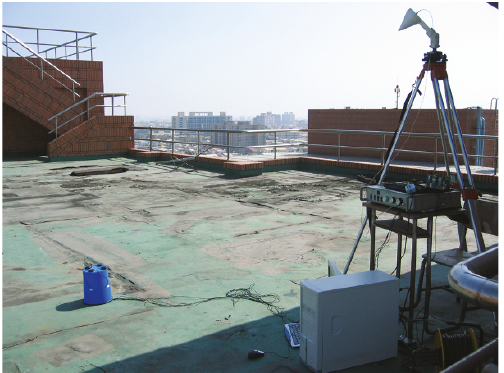
Figure 7: Photo of experiment location.